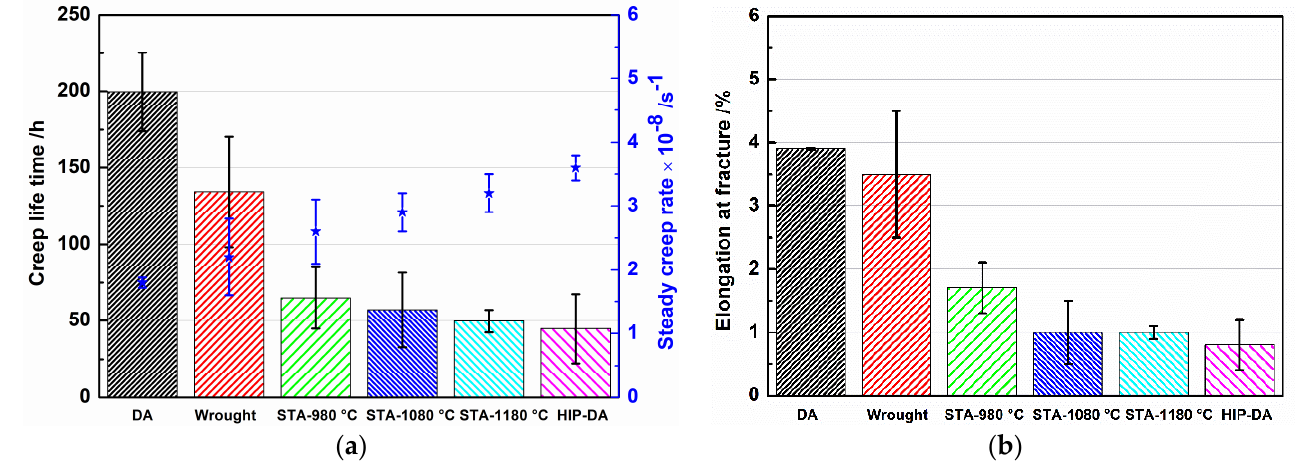
Figure 4. Graphs of the t r and the ε ̇ min ( a ) and the ε f ( b ) for all investigated specimens. Table 2. Summary of creep results for the t r , the ε ̇ min and the ε f for all tested cases. DA Wrought HA-1080 °C HA-1180 °C